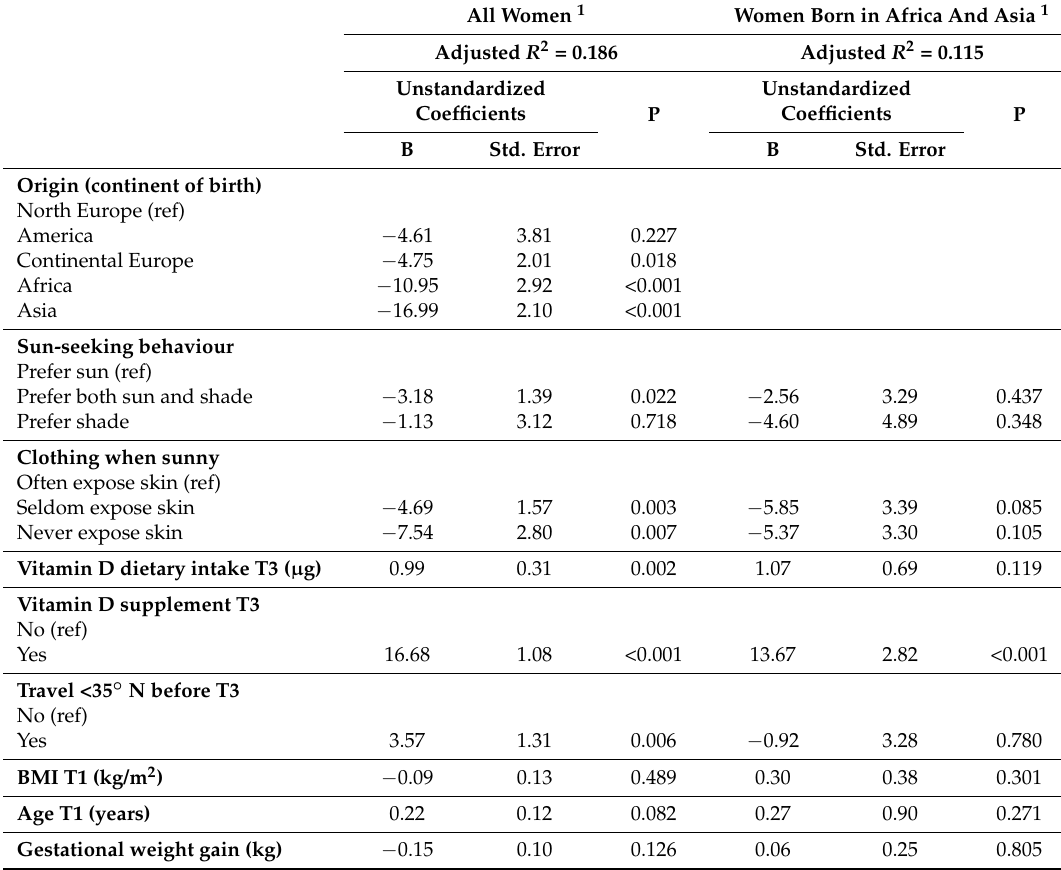
Table 3. Determinants of season corrected change in 25(OH)D during pregnancy (T3–T1), for the whole cohort and the subgroup of women born in Africa and Asia.